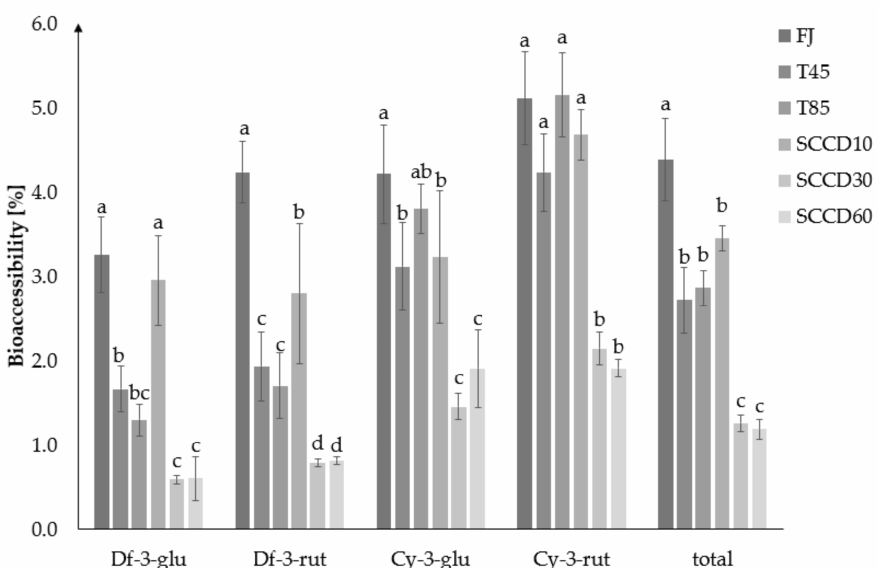
Figure 3. Bioaccessibility of blackcurrant juice anthocyanins in the dialysate after different processing: FJ-fresh juice; T45-thermal treated juice at 45 ◦ C; T85-thermal treated juice at 85 ◦ C; SCCD10-juice after super critical carbon dioxide at 10 MPa; SCCD30-juice after super critical carbon dioxide at 30 MPa; SCCD60-juice after super critical carbon dioxide at 60 MPa. (The same letter above the bars indicates no significant difference between the mean ( p ≤ 0.05) bioaccessibility of the samples after the different type of